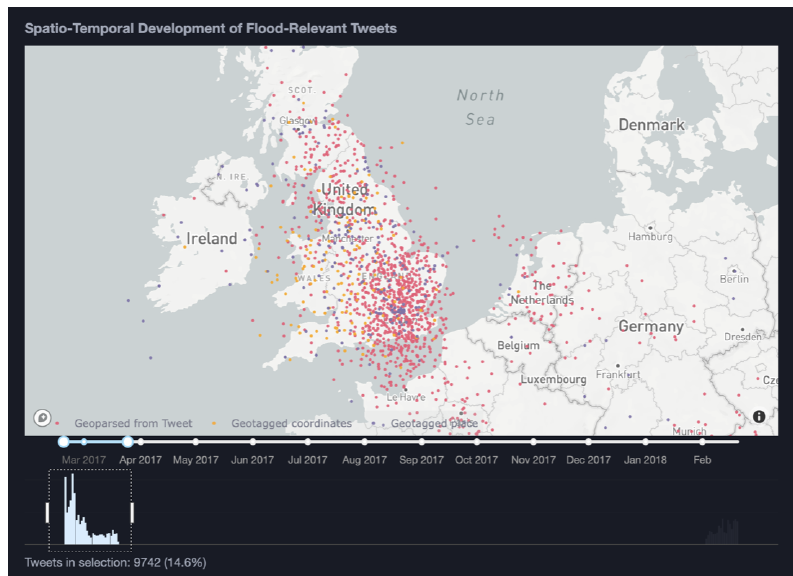
Figure 10. Selection of peak in February–March 2017 on histogram and zoom to the UK area on scatter map.